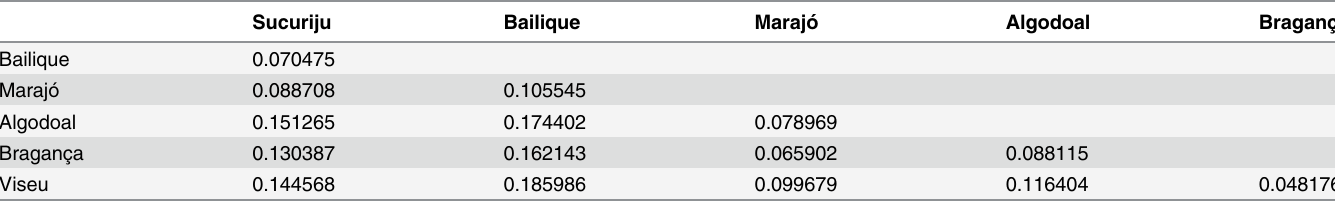
Table 2. Pairwise F ST values across all sampled populations of Rhinella marina .